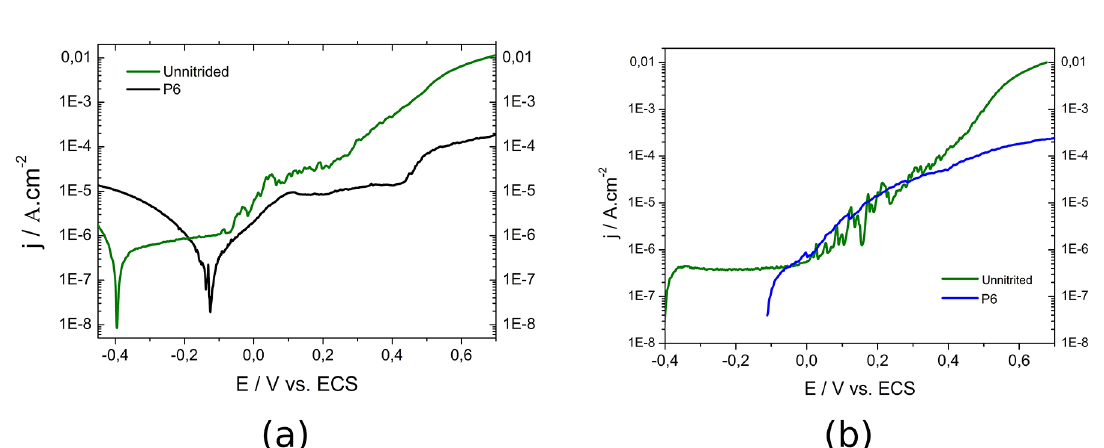
Figure 8. Potentiodynamic anodic polarization curves for samples nitrided at 6 Torr, showing different height (a) height =3.85 mm (b) height = 2.00